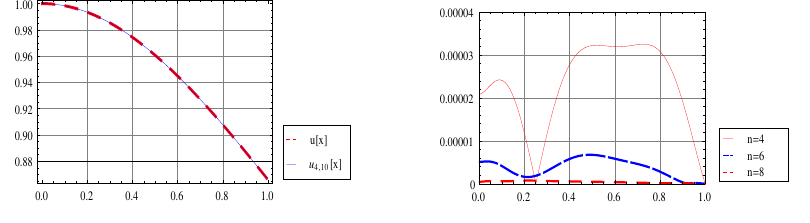
Figure 2. Comparison of exact solution u ( x ) and approximate solution u 4 , 10 ( x ) (left side) and E (right side) for Example 2( k = 4).